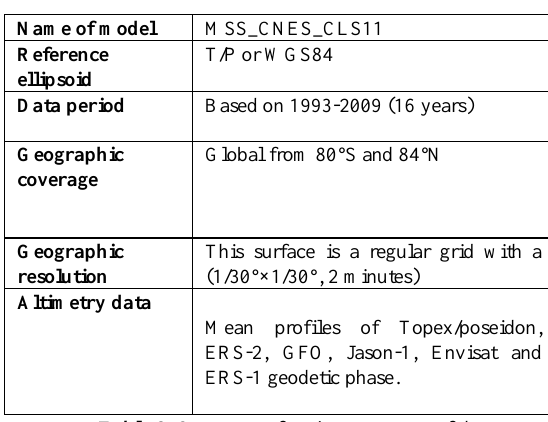
Table 3 . Summary of main parameters of the MSS_CNES_CLS11 model (https://www.aviso.altimetery.fr).